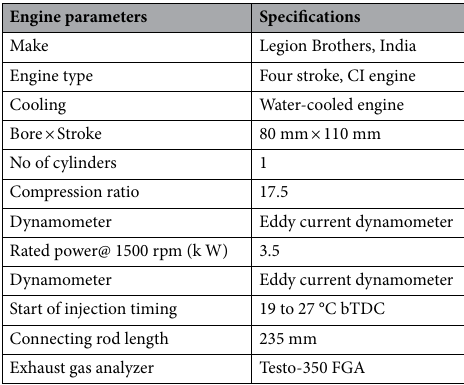
Table 4. The detailed specification of test engine.